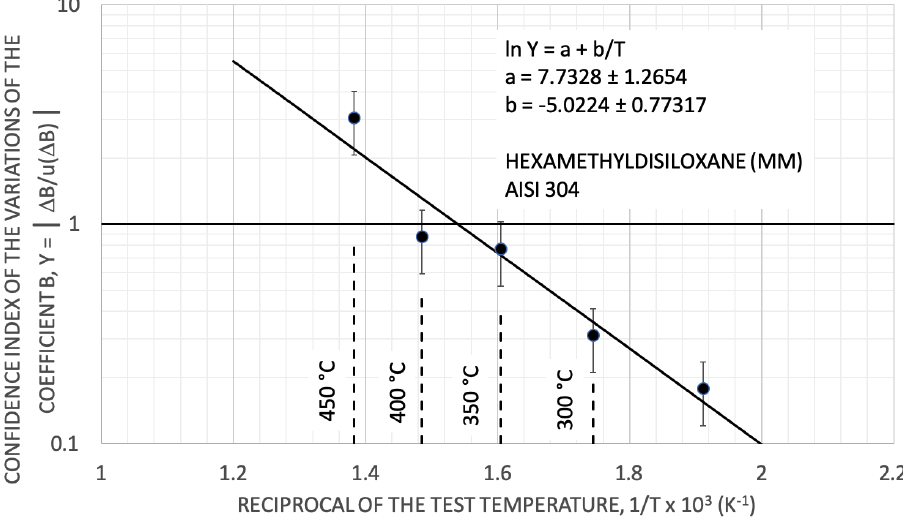
Figure 5. Relative variations in the B coefficient in Equation (1) for a sample of hexamethyldisiloxane (MM) after its keeping at different temperatures for one hundred hours each